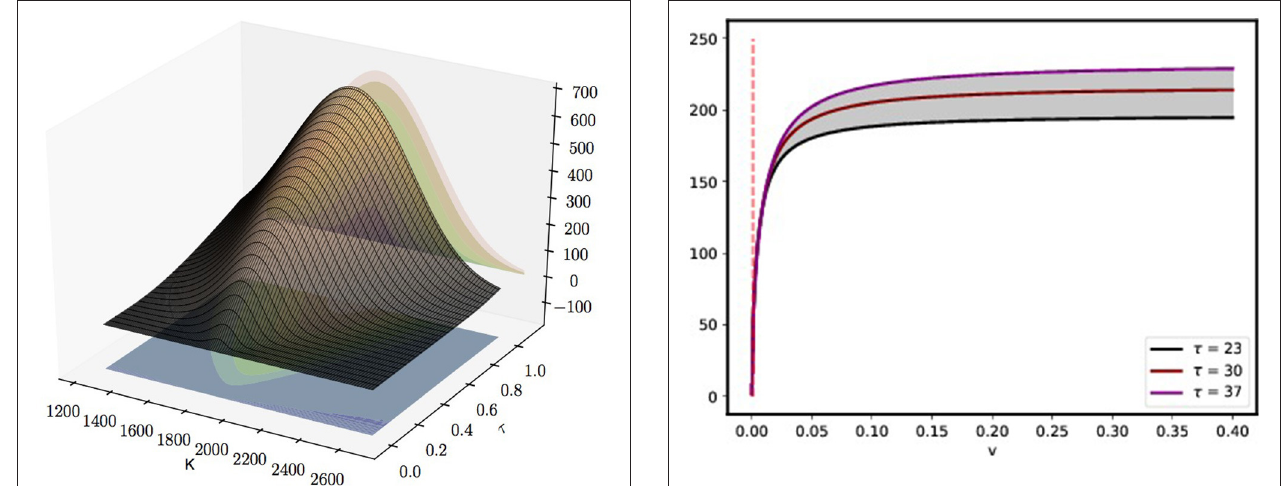
FIGURE 7 | Vega for a European option price by Heston’s model over various variances for a fixed strike K 1,845.73 at the spot price of the underlying. = Vega drops for small variances. The dashed line corresponds to √ v =